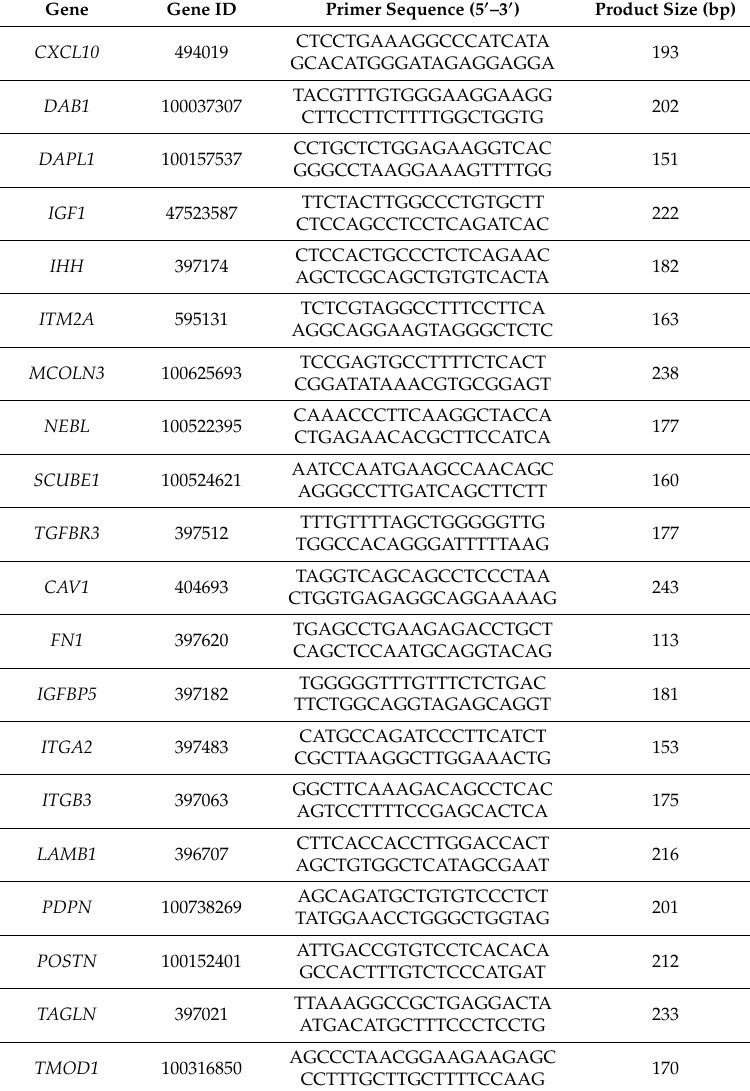
Table 2. Oligonucleotide sequences of primers used for RT-qPCR analysis. Gene Gene ID Primer Sequence (5 (cid:48) –3 (cid:48)